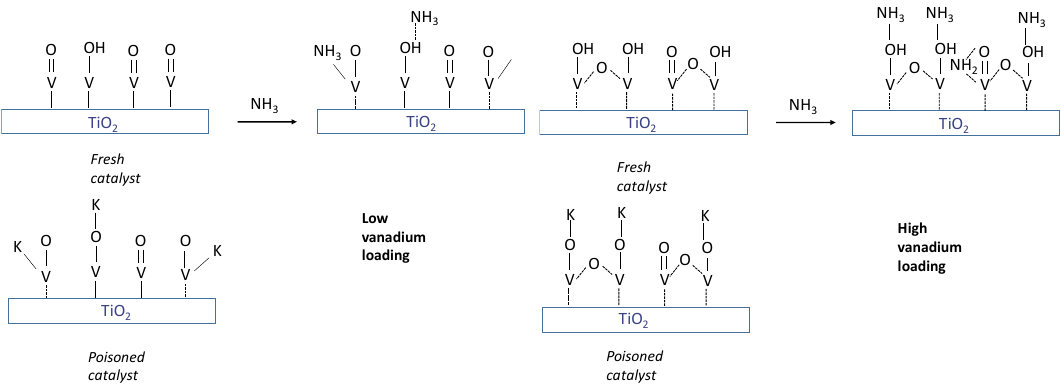
Figure 2. NH 3 adsorption on fresh catalysts with low (left) and high (right) V 2 O 5 loading. The same sites are poisoned by K, thus hindering NH 3 adsorption. Adapted from Reference [28].